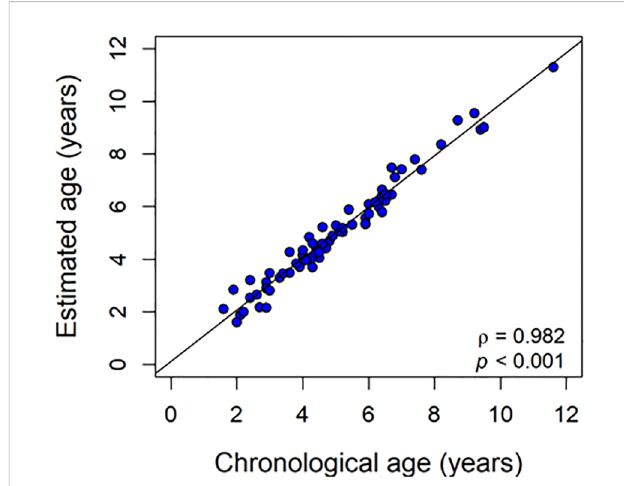
FIGURE 4 Typical epigenetic clock in fi sh. Estimated age is regressed against chronological age. In this hypothetical example, the sample size is 70, a number capable of producing good results while accuracy, represented by the correlation coef fi cient, is 0.95 or higher, common in the latest developed piscine epigenetic